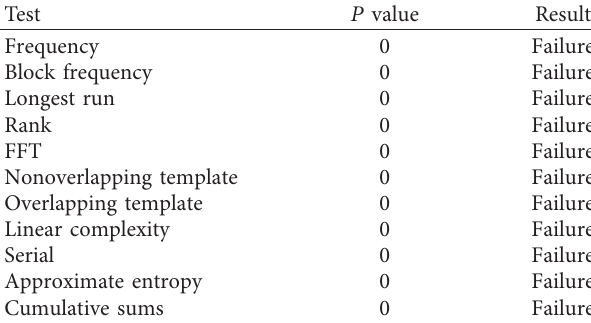
Table 1: Pseudorandom properties of chaotic system.